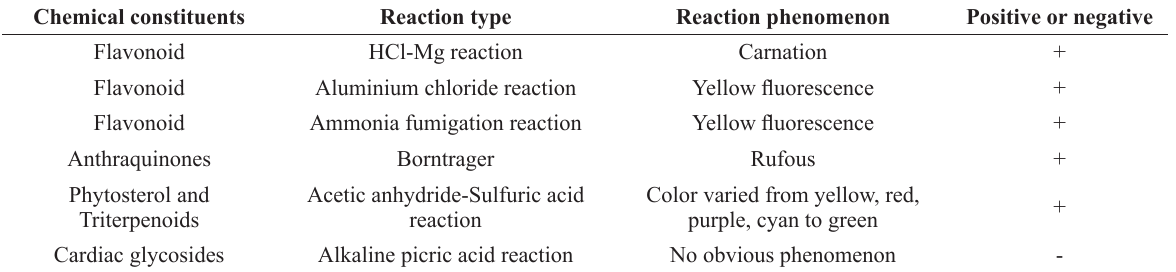
Preliminary phytochemical screening of alcohol extract from Desmodium caudatum .